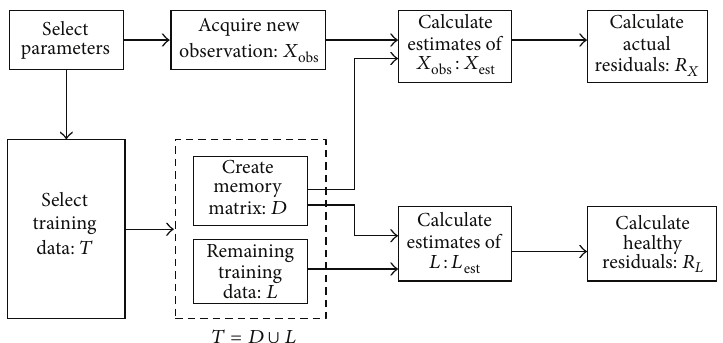
Figure 2: State estimation process based on MSET [20].